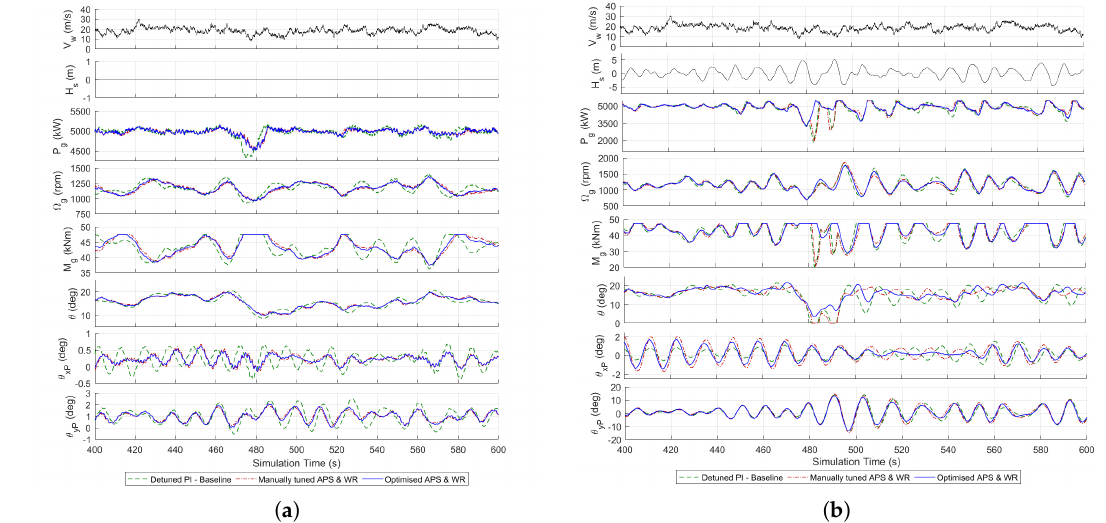
Figure 8. Time-domain simulation results. ( a ) V hub = 19 m/s and H s = 0 m. ( b ) V hub = 19 m/s and H s = 6 m.